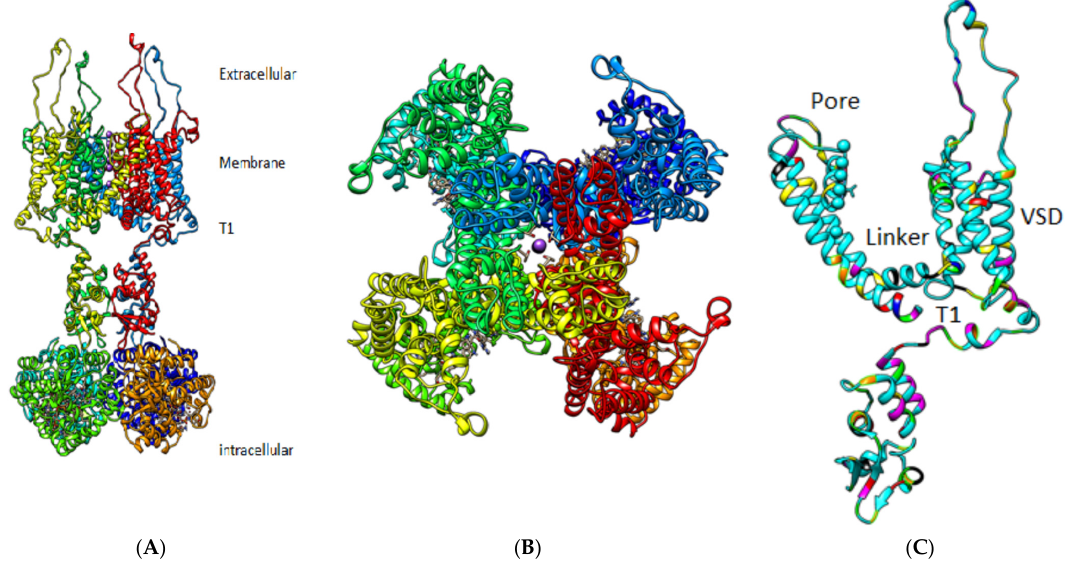
Figure 1. General view of a K v 1.2 channel from the 3Lut coordinates. ( A ): View from the membrane (side view). Two of four domains are shown, with front and back domains deleted to allow the structure to be seen. ( B ): A 90° rotation of the channel, showing the pore. In neither ( A ) nor ( B ) are individual amino acids shown. The T1 section is somewhat visible in ( A ). Neither ( A ) nor ( B) make it clear that the linker is not entirely continuous unless the water is included, although water is not shown in these figures. ( C ): A single domain is shown, making the domain crossing clear. Although some individual amino acids are shown with specific colors, it is too difficult in this view to see the relation of the actual amino acids, and again the water is not shown. The region that was calculated is labeled here as linker and T1, although it is hard to see the exact boundary in this type of figure. Figures 2–4 show the specific calculations, with individual amino acids and water explicit and clear. 2. Methods We have carried out quantum calculations on a critical 563 ‐ atom section (which includes 28 water molecules) of this path, and can easily see what appears to be a proton wire for linking this to the VSD at one end and to the gate at the other; in fact, two paths can be found, one of which involves the T1 moiety of the intracellular section of the channel, which, based on experiment, is necessary, as noted in the introduction. The quantum optimization (energy minimization) of this portion of the intracellular section of the channel includes much of the linker of the VSD to the pore (the S4–S5 linker, together with a small part of transmembrane segment S6). The optimization was done at the HF/6 ‐ 31G** level, using Gaussian09 [51]. The calculation starts from the X ‐ ray structure of the open conformation, with the protons added by a normal mode analysis in the 3Lut structure [31,52]. The calculations had the protons on the following pairs of amino acids: (1) K312 and R326; (2) one proton shared by the K312—R326 pair (which we count, for the present, as being on R326), one on E420; (3) E136 (T1) and E420. The two protons were moved initially by hand; they were started in different positions in the three optimizations. In each optimization, the same 33 atoms were frozen, so that there was no possibility of any overall translation of the system. All 33 frozen atoms were C or N atoms that were part of peptide bonds not in either proton path. The optimizations were begun with the water molecules oriented in arbitrary fashion, without any particular order. They were not set up to be hydrogen bonded, nor were any of the side chains of the amino acids. The latter depended in a large part on the X ‐ ray structures; since these did not include